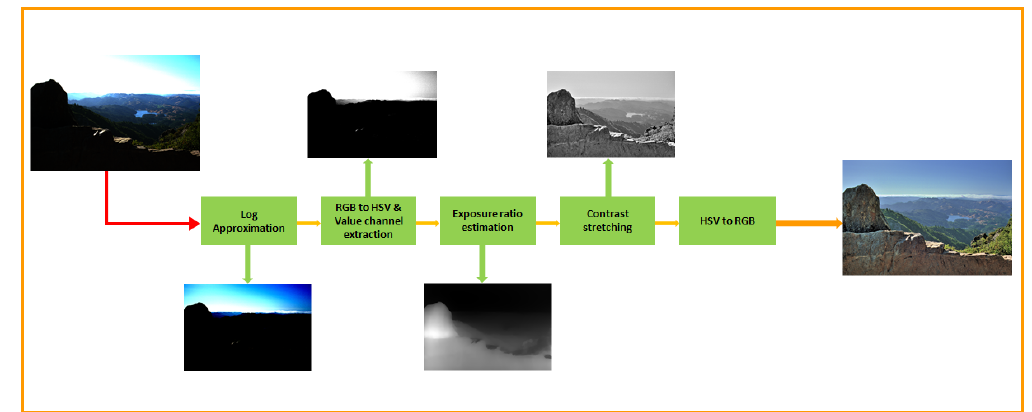
Figure 2. The left-most image is the input image, and the image at the most right position is the tone mapped output image. For ease of view, we have presented the normalized view of the exposure. Here, we estimate the exposure ratio [36] with our proposed adaptive parameter settings, and we have improved the contrast stretching with the help of this weight matrix extraction scheme